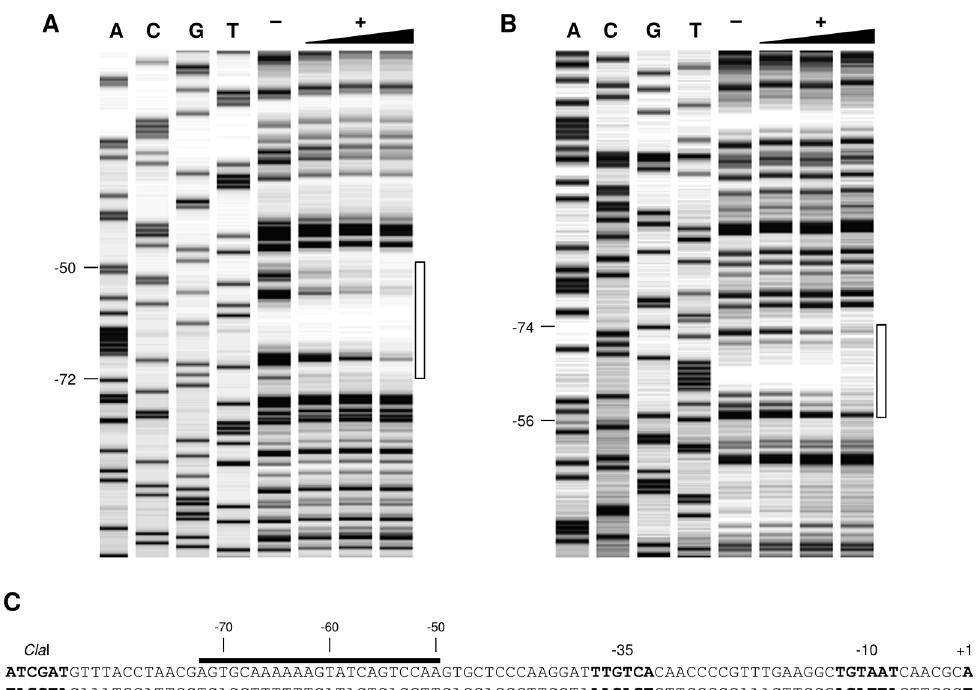
Fig 6. DNase I footprinting analysis of the MtlR binding site. One representative experiment is shown. The sequencing reaction (ACGT) of pJOE7771.1 is shown on the left. Footprinting reactions were performed with 2.28 nM Cy5-labelled operator DNA (-) without or (+) with MtlR (66, 132 or 264 nM). The protected nucleotides are indicated by empty rectangles on the right and the bases that mark the borders of the protected region are indicated on the left. (A) Coding strand. (B) Non-coding strand. (C) Presentation of the nucleotides protected by MtlR in the sequence 5 ’ to P mtlE by black lines above (coding strand) and below (noncoding strand) the